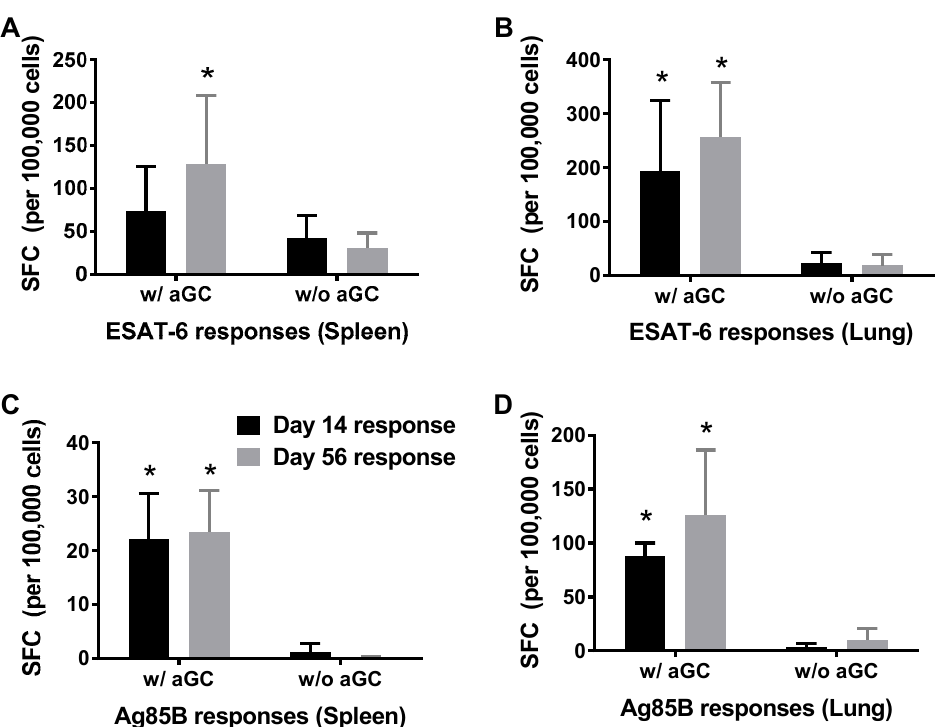
Figure 3. Induction and persistence of antigen-specific immunity after sublingual immunization with Mtb proteins Ag85B and ESAT-6 in the presence of α -GalCer adjuvant. C57BL/6 female mice were immunized as in Figure 1 by the sublingual route and sacrificed on days 14 and 60 for determining the effector and long term persistent T cell responses, respectively. Cells isolated from spleen and lung were analyzed for IFN- γ producing cells specific for ESAT-6 (Panels ( A , B )) and Ag85B (Panels ( C , D )) using a standard IFN- γ ELISpot assay. Responses specific to the Mtb proteins were determined by subtracting the background values of medium stimulation from that of the individual protein stimulation and the mean ± S.D values were expressed as spot forming cells (SFC) per 10 5 input cells. See methods section for details and cut-off values for positive responses. Significant responses (*, p < 0.05) between groups vaccinated in the presence and absence of α -GalCer (w/aGC and w/o aGC, respectively) were noted. The experiment was performed using 5 mice/group and repeated 2 times.